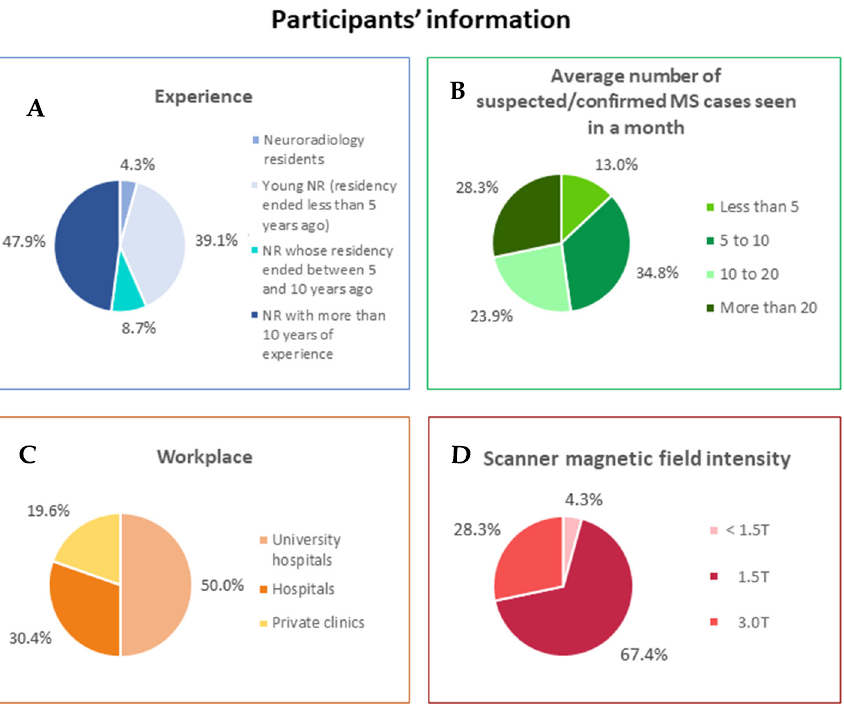
Figure 1. Participants’ information. Pie charts represent ( A ) experience in neuroradiology field; ( B ) average number of suspected/confirmed Multiple Sclerosis cases usually seen in a month; ( C ) workplace; ( D ) scanner magnetic field intensity. Data are show as